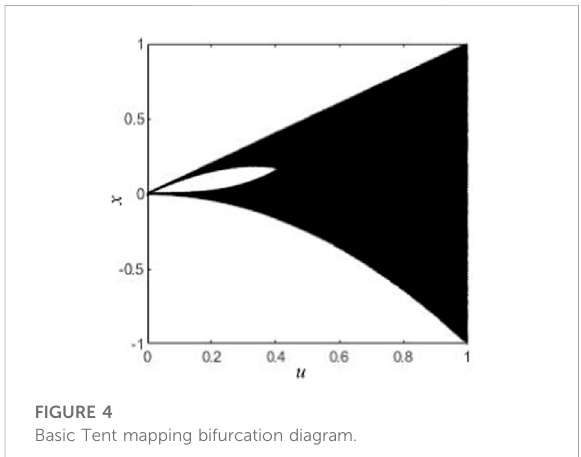
FIGURE 4 Basic Tent mapping bifurcation